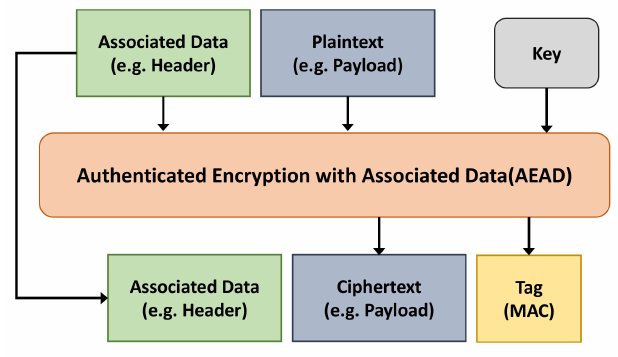
Figure 1. Principle of the AEAD